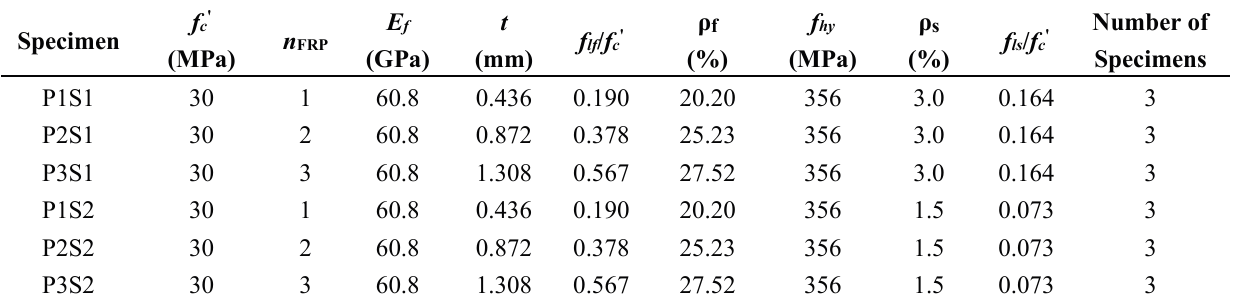
Table 1. Details of confined concrete cylinder specimens (150 mm × 300